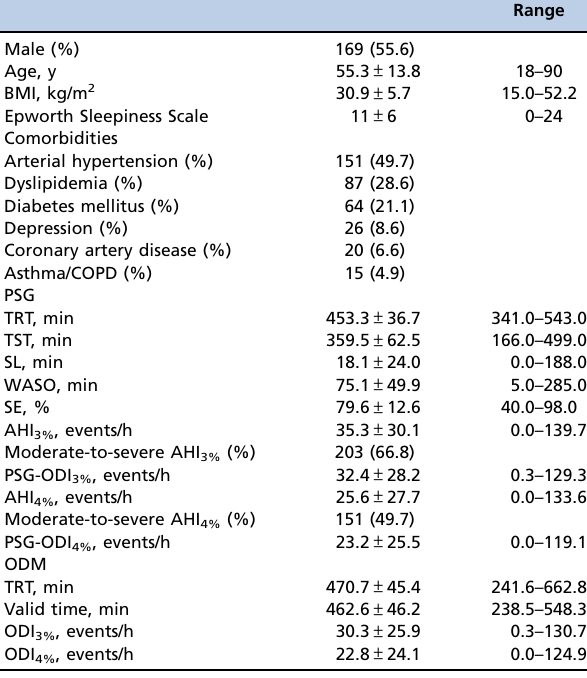
Table 1 - Characteristics of the sample population.